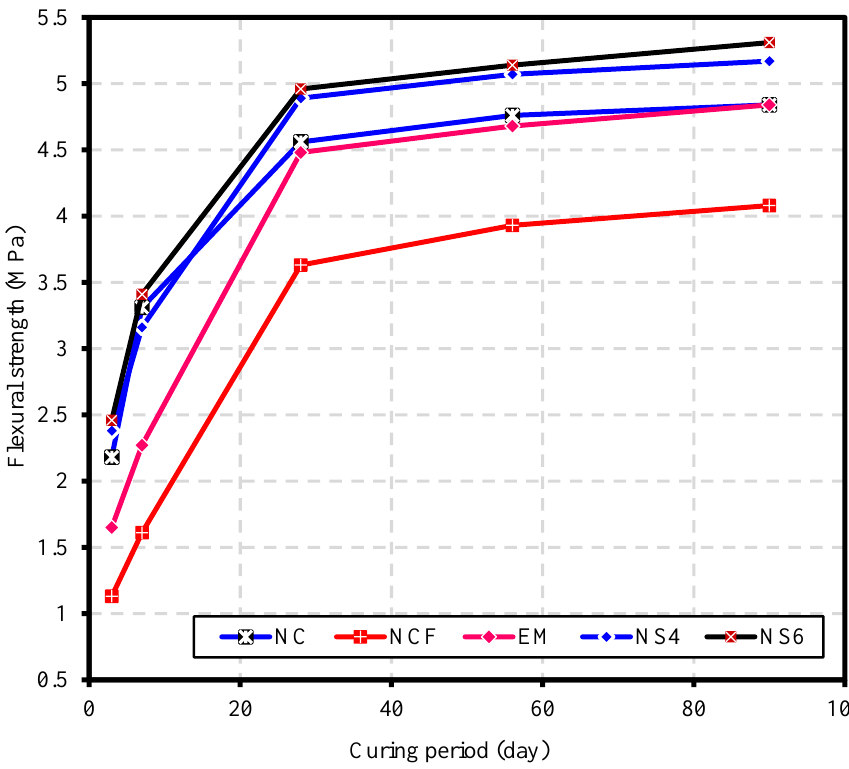
Figure 9. Flexural strength against curing period of various studied specimens.